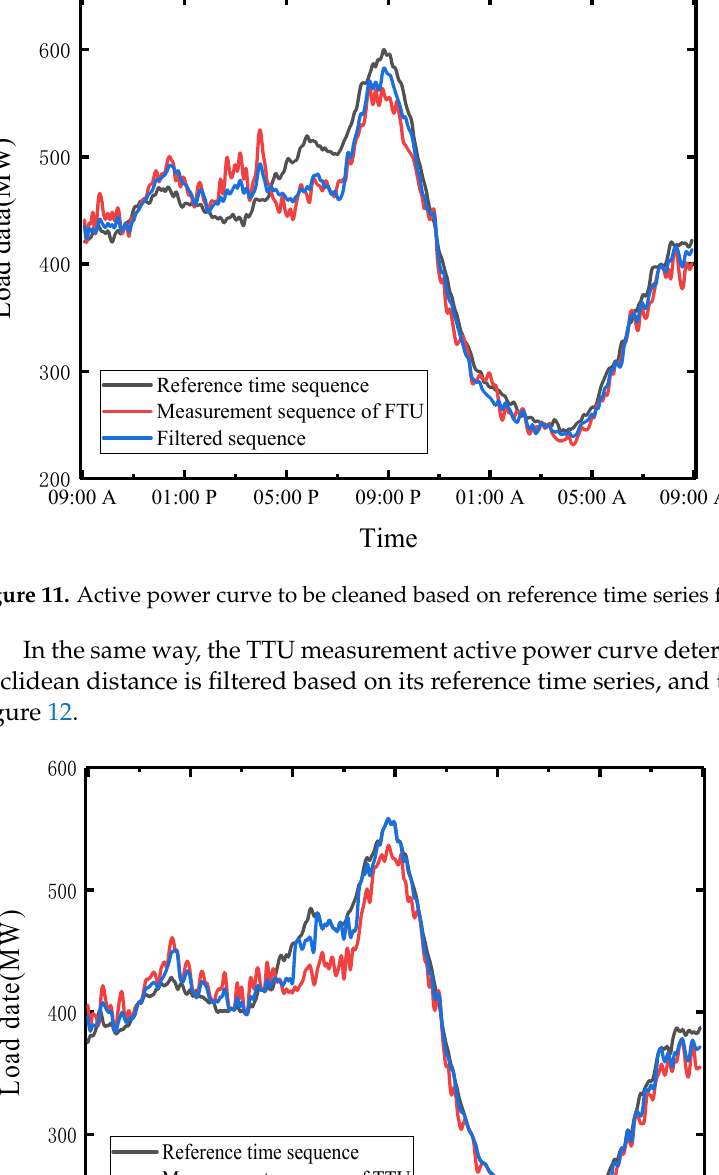
Figure 12. TTU measured active power curve based on reference time series filtering.